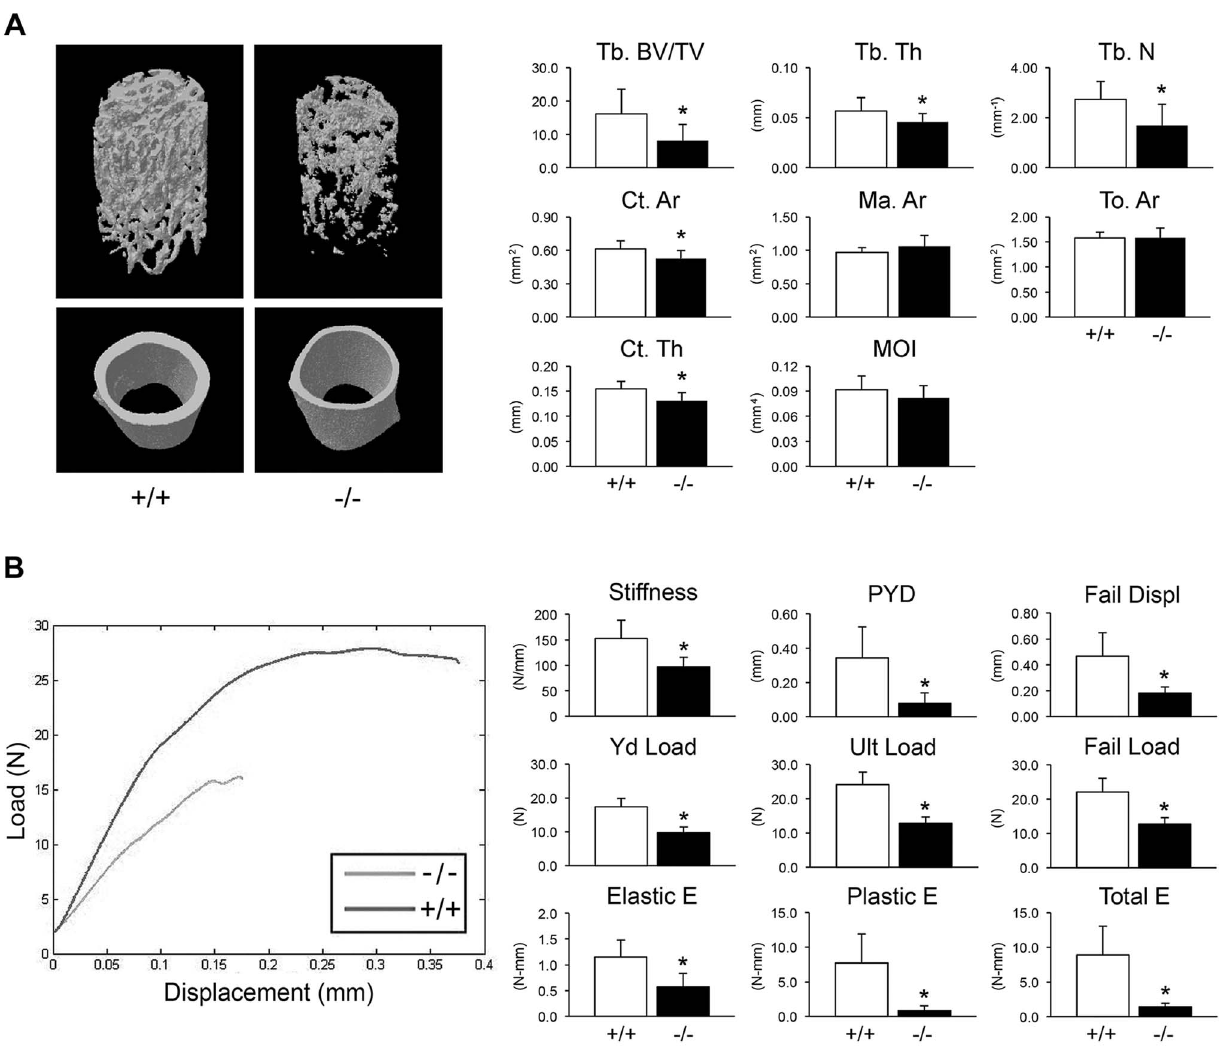
Figure 3. Whole bone structural and mechanical properties. (A) Structural parameters of wild-type ( + / + ) and homozygous ( 2 / 2 ) femora at 8 weeks of age characterize reduced bone formation in CyPB-deficient mice (n=9/genotype). Left , 3D reconstructions illustrate reduced trabecular and cortical bone volumes. Right , Trabecular parameters are decreased in homozygous ( 2 / 2 ) femora, including reduced bone volume (Tb BV/TV, p=0.01), thickness (Tb Th, p=0.04) and number (Tb N, p=0.01). Cortical bone parameters of CyPB-deficient mice are also reduced, with reductions in cortical thickness (Ct Th, p=0.003) and area (Ct Ar, p=0.02). (B) Left , Representative load-displacement curve demonstrating differences between samples selected for median post-yield displacement. Right , CyPB-deficient femora are weaker in yield (Yd Load, p=1.9 6 10 2 6 ), ultimate (Ult Load, p=8.9 6 10 2 7 ) and failure loads (p=2.1 6 10 2 5 ), with reduced stiffness (p=0.001). Ppib 2 / 2 femora are also more brittle than wild-type femora, as demonstrated by decreased post-yield displacement (PYD, p=0.001). Reduced toughness of Ppib 2 / 2 femora is evident by decreases in the elastic and plastic energy (E) values (p=0.001 and 0.0003, respectively).